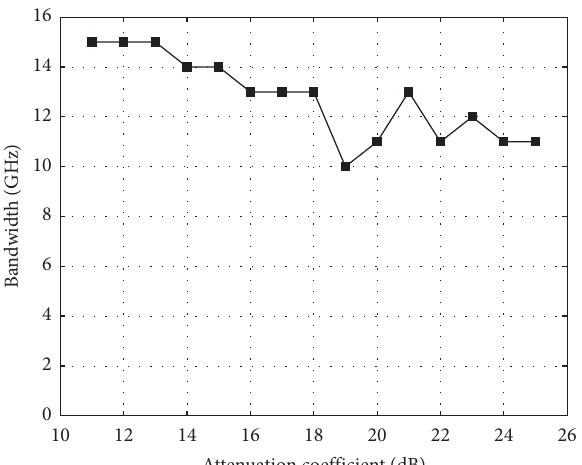
Figure 3: Influence of the output optical power of the SFP optical module on the MFC. The X -axis is represented by the attenuation coefficient of the VOA.